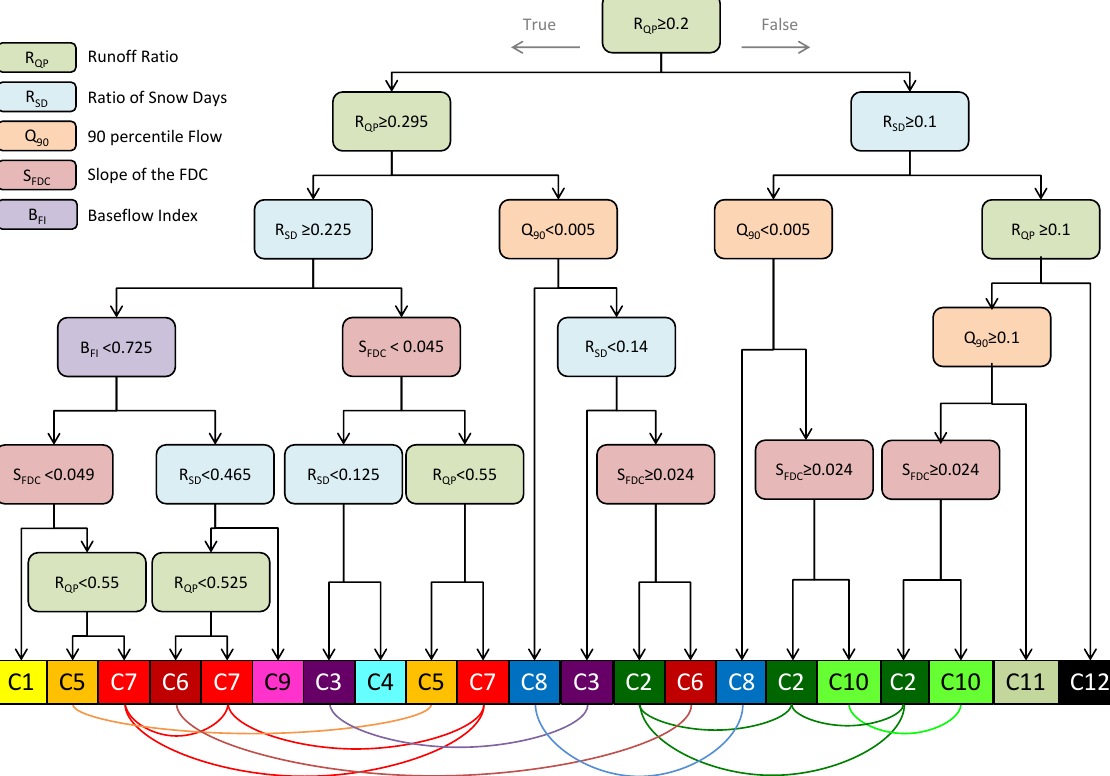
Fig. 3. The CART decision tree shows the classification tree based on the values of signatures used in this study. This structure is utilized to model the results of the AutoClass clustering algorithm for predicative capability.